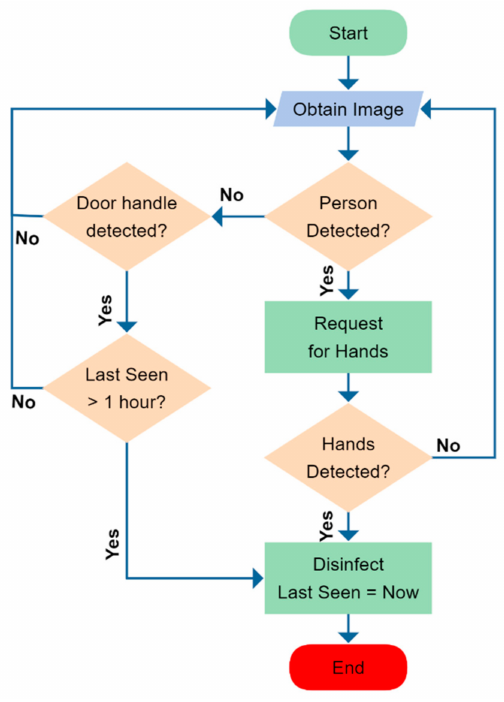
Figure 7. Algorithm for autonomous